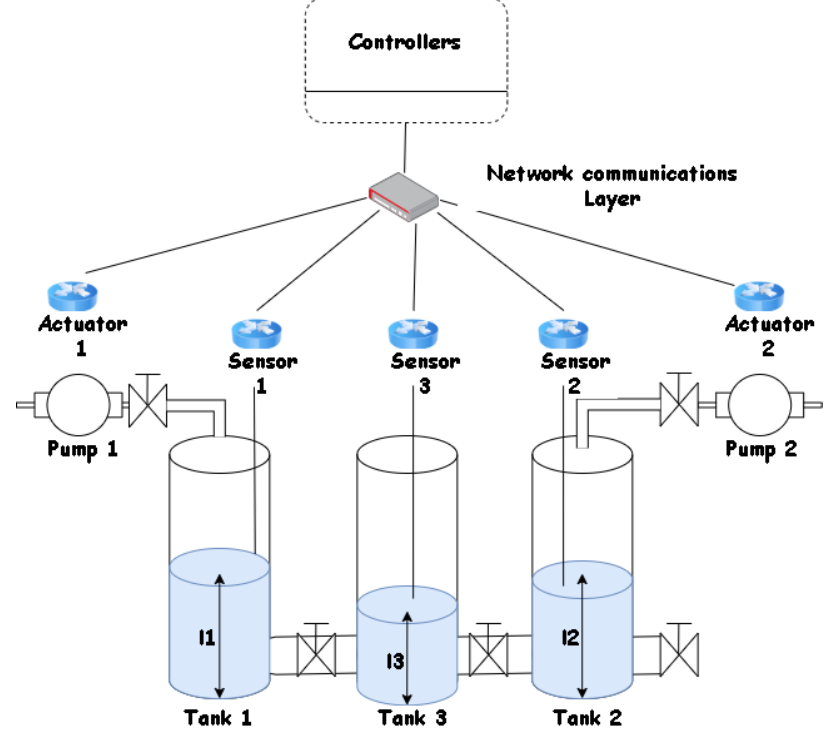
Figure 11. Interconnected tank